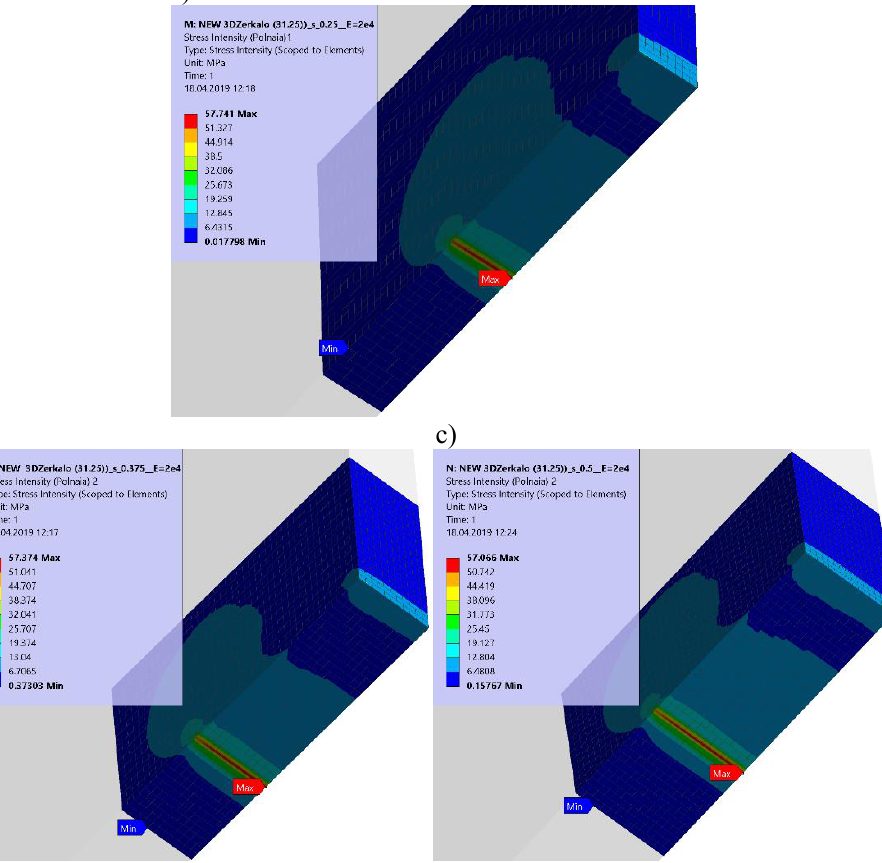
Fig. 12. Distribution of stress intensity σ i on the bottom surface of the deep beam y =0(0 ADH ) for the following thickness values: a) H =0.50 m; b) H =0.75 m; c) H =1.00